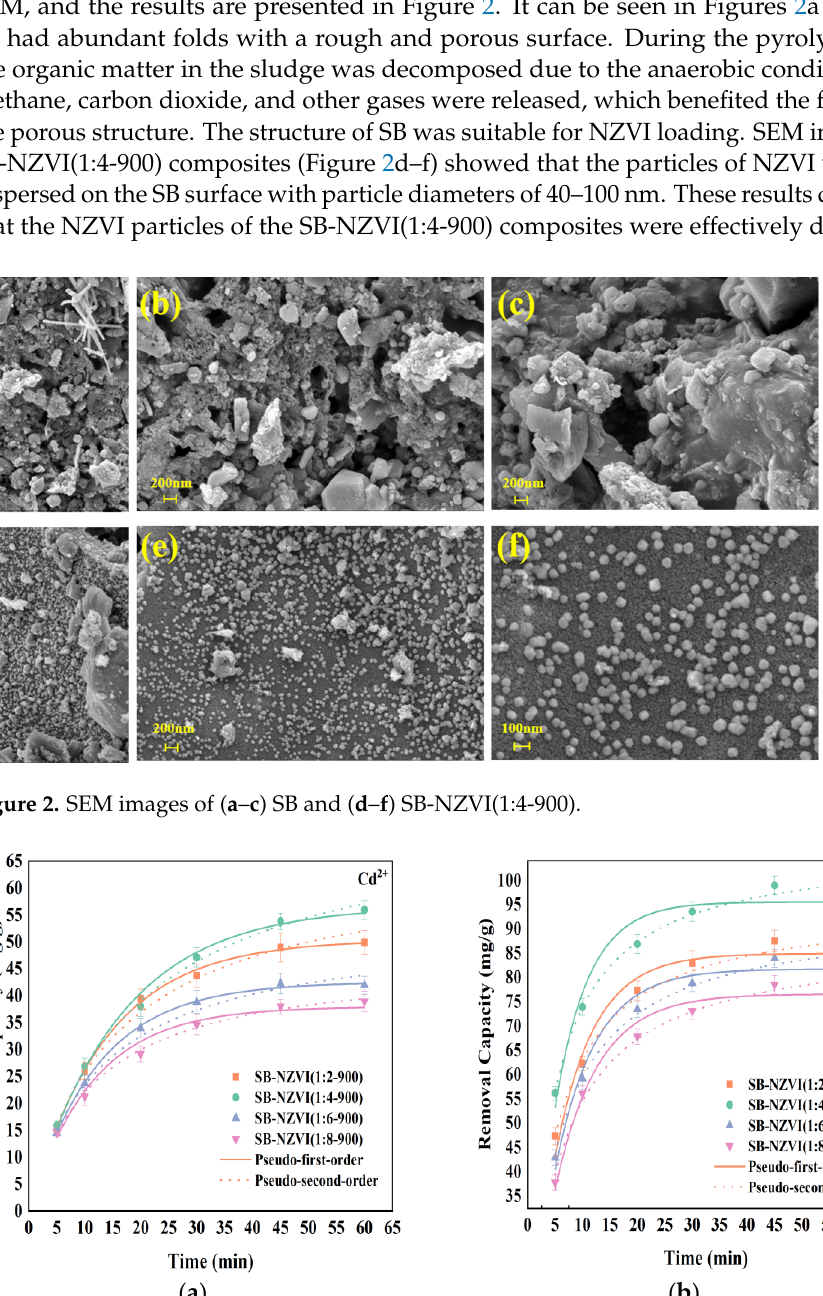
Figure 1. XRD patterns of ( a ) SB-NZVI at different temperatures and ( b ) with different mass ratios of Fe to sludge.